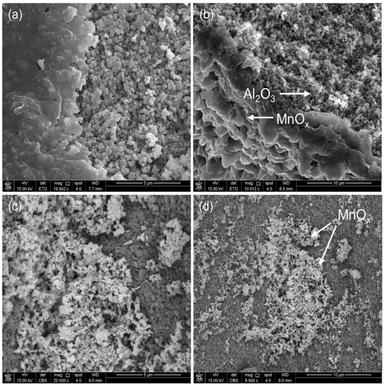
SEM images of the MnOx catalyst coatings; (a) & (b) MnOx on alumina from KMnO4 precursor (fractured surface) – 800 ◦C in air, (c) & (d) MnOx from MnAc precursor – 800 ◦C in air.